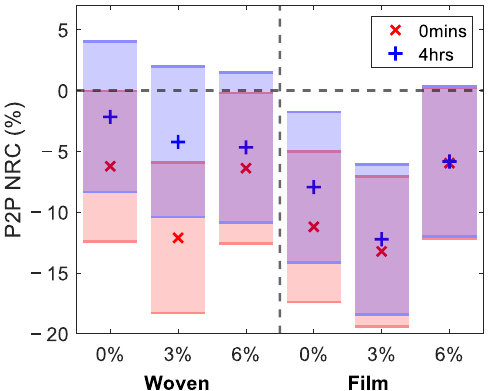
Figure 9. The results of performing the one-way analysis of variance test on the NRC in the P2P sampled 52 s into occlusion for all subjects; the markers show the estimated mean of the distribution of responses to the patches. The shaded bars are the 95% confidence intervals calculated using the Tukey – Kramer test.